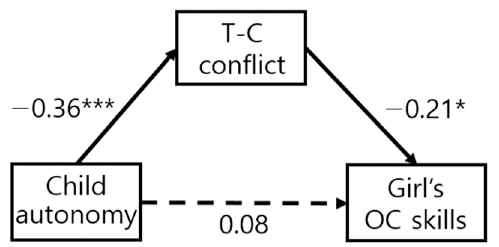
Figure 3. Object control skills of girls. * p < 0.05, *** p < 0.001.